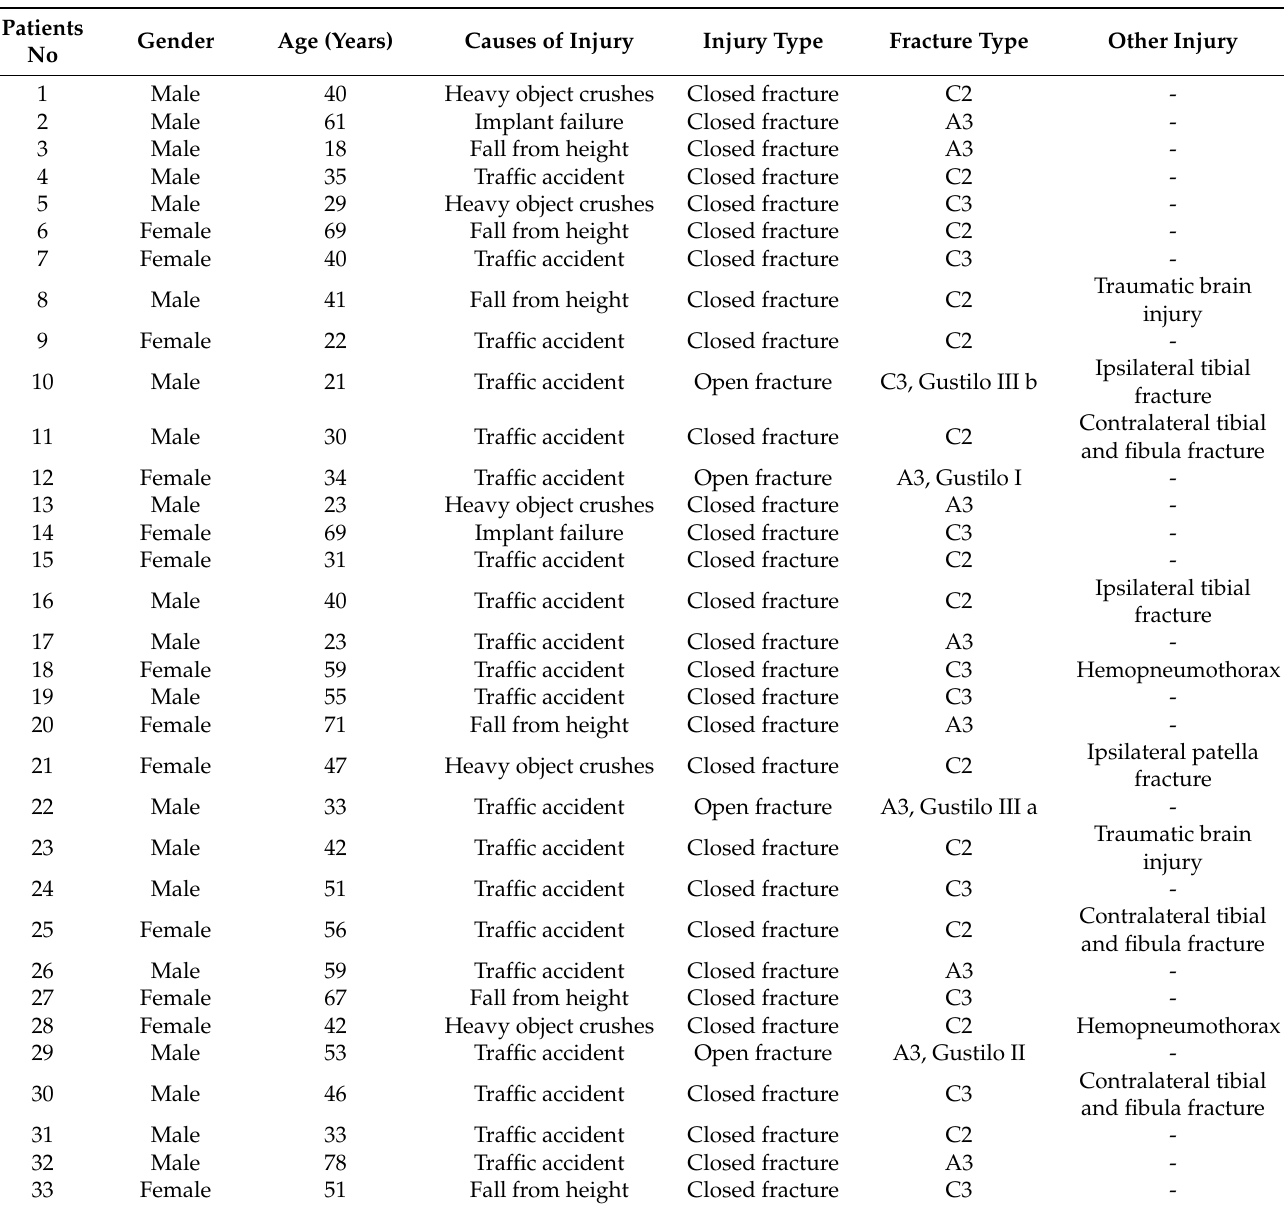
Table 1. Clinical parameters of the